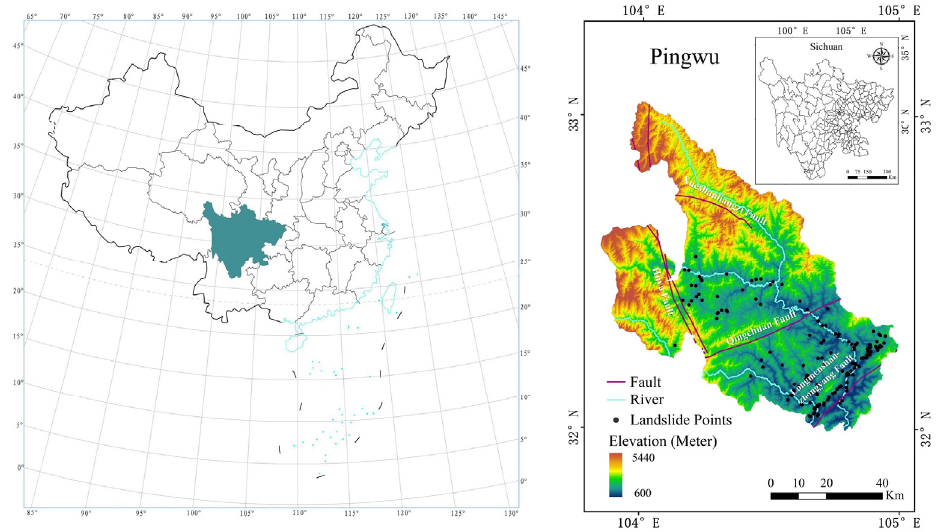
Figure 1. Study area and landslide distribution.